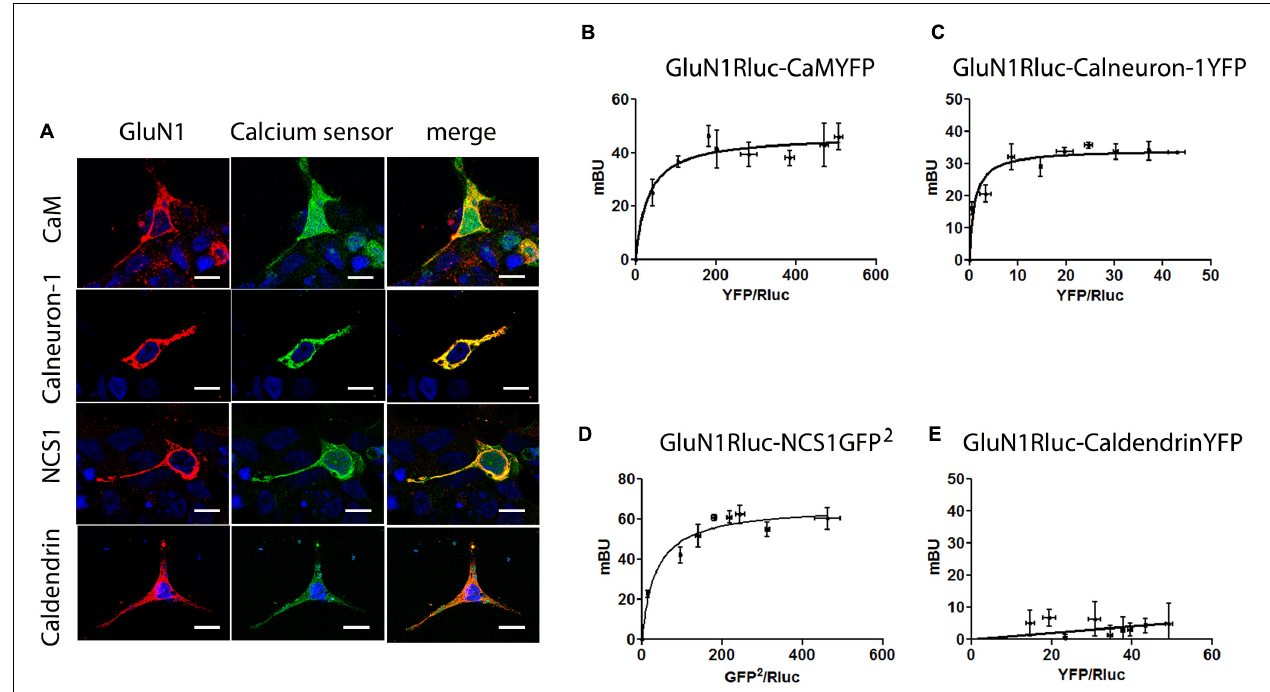
FIGURE 1 | The NMDAR receptor interacts with calmodulin, calneuron-1, and NCS1. (A) Confocal microscopy images of HEK-293T cells transfected with cDNAs for GluN1Rluc (0.5 µ g), GluN2B (0.3 µ g), and CaMYFP (0.5 µ g), calneuron-1-YFP (0.75 µ g), NCS1YFP (0.5 µ g), or caldendrinYFP (0.75 µ g). Calcium sensors fused to YFP were identified by their own fluorescence (green) and GluN1Rluc by immunoreactivity (red); co-localization is shown in yellow; scale bars: 10 µ m. (B–E) BRET [BRET 1 except BRET 2 in (D) ] saturation experiments in HEK-293T cells transfected with cDNAs for GluN1RLuc (0.3 µ g), GluN2B (0.3 µ g), and increasing amounts of cDNA for CaMYFP (0.05–0.4 µ g) (B) , calneuron-1YFP (0.05–1 µ g) (C) , NCS1-GFP 2 (0.05–0.6 µ g) (D) , or caldendrinYFP (0.05–1 µ g) (E) . Values are the mean ± SEM ( n =